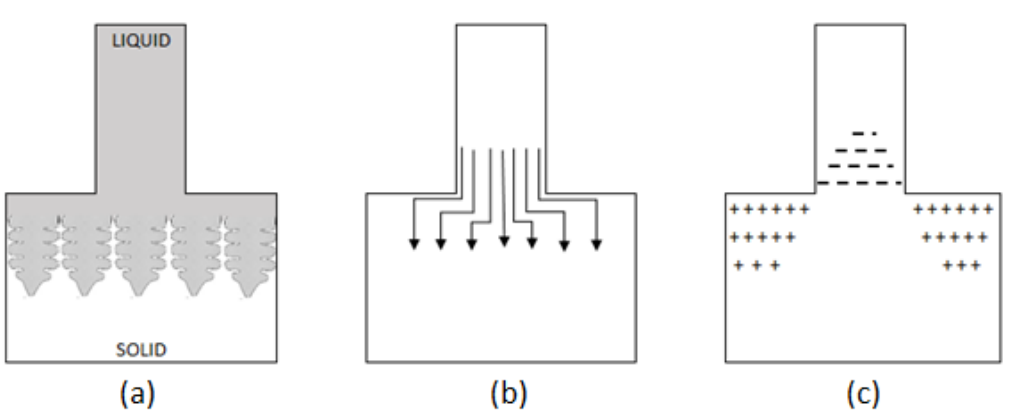
Figure 2. Macrosegregation in a unidirectionally solidified casting of reduced cross section. Schematic diagrams of ( a ) solidification when location of the reduced cross section is just below the liquidus temperature, ( b ) flow lines for feeding solidification shrinkage at this time of solidification, ( c ) resulting macrosegregation.